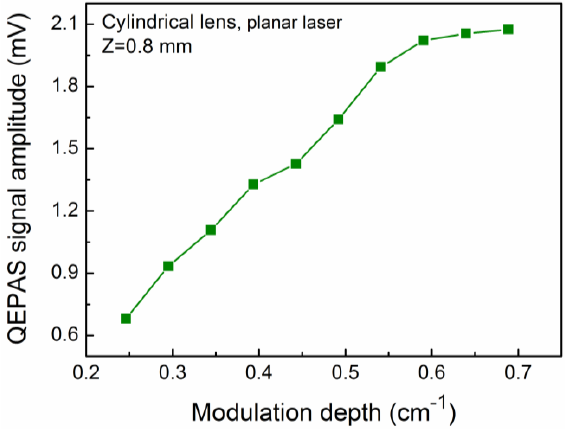
Figure 5. Measured QEPAS signal amplitude as a function of the modulation depth at Z of 0.8 mm for a cylindrical lens-based QEPAS sensor.